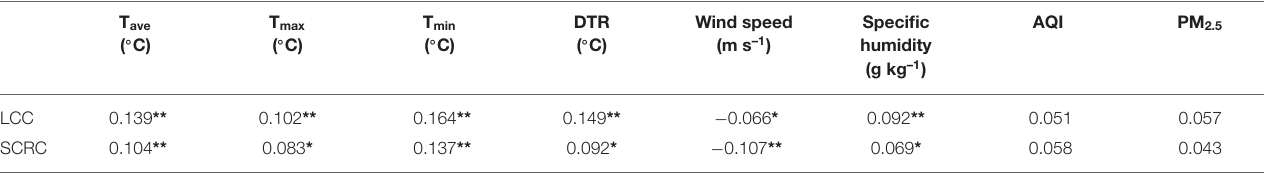
TABLE 1 | The Linear correlations coefficient (LCC) and Spearman coefficient of rank correlation (SCRC) between confirmed cases and meteorological and environmental factors.